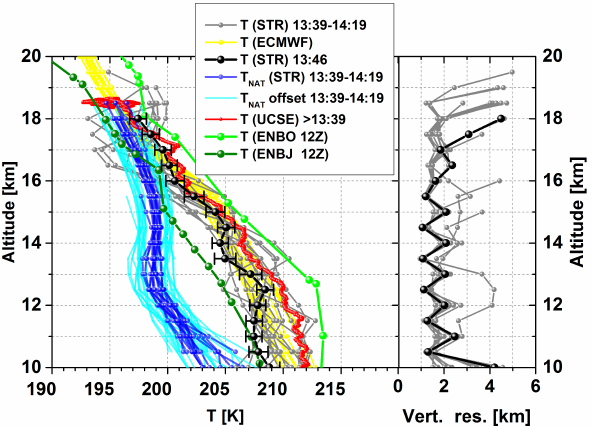
Figure 8. Correlation of O 3 with HNO 3 ( g ) retrieved from the MIPAS-STR observations together with combined random and sys- tematic 1 σ -uncertainties of example data points. Blue data points: correlation outside the polar vortex. Green data points: correlation inside the polar vortex and inside/below the observed PSC (data points only where PSC is sufficiently transparent for trace gas re- trieval; compare Figs. 6b and A1b). Magenta data points are a sub- set of the vortex data points close to flight altitude ( ≥ 18km) inside the PSC. Cyan dashed line: extrapolation of extra-vortex correlation to higher mixing ratios (i.e.,